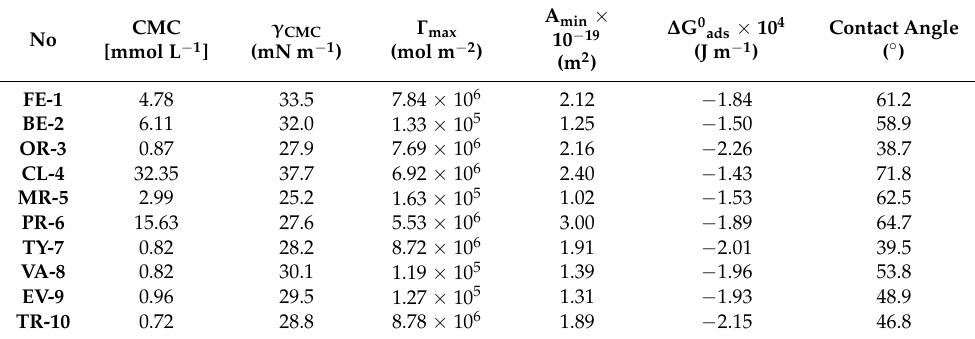
Table 6. Cytotoxic properties of the analyzed compounds.